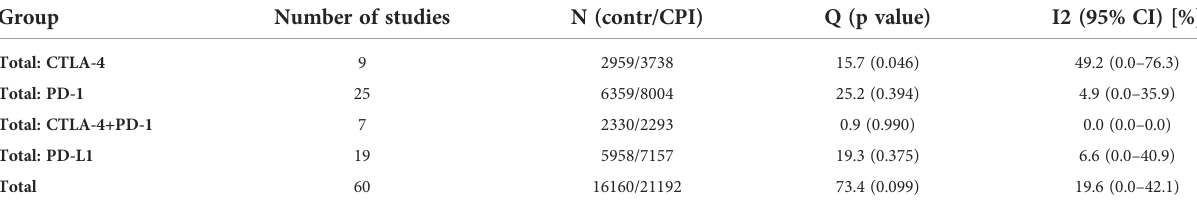
TABLE 4 Heterogeneity estimates for all studies/study arms.